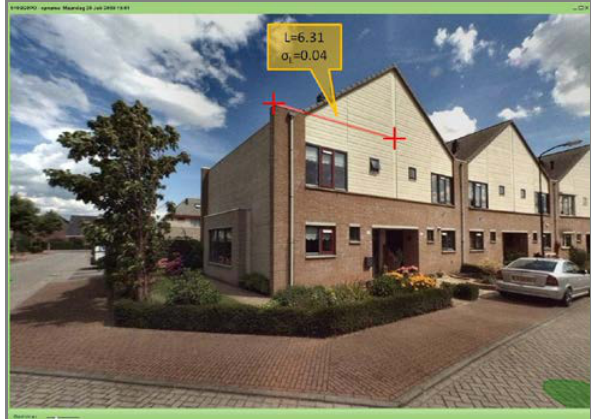
Figure 6. Example of point measurement in a single image